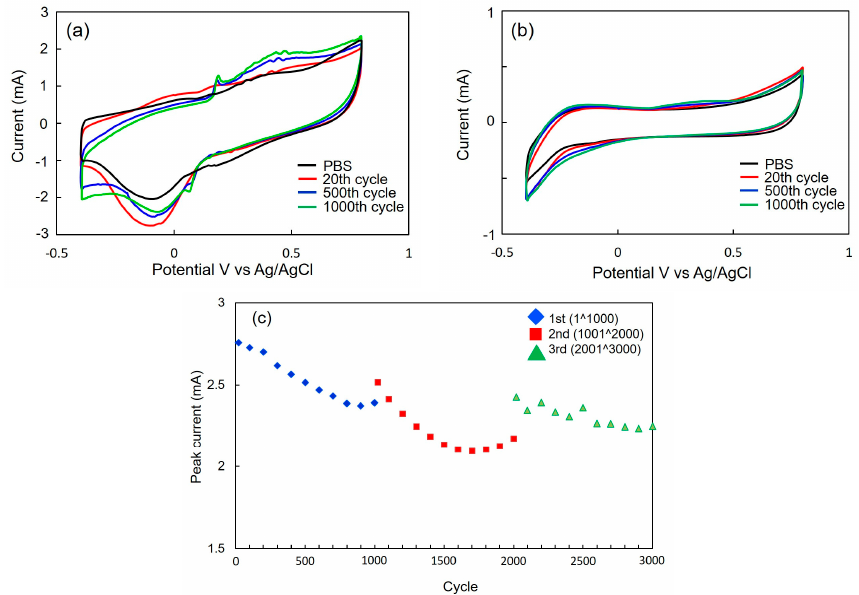
Figure 3. Cyclic voltammogram responses for the 20th, 500th, and 1000th scans of first test of 1000 cycles using ( a ) the Pt-CNW electrode and ( b ) the CNW electrode without Pt nanoparticles in PBS solution with 240 µ M of H 2 O 2 , together with a CV curve for the first scan without H 2 O 2 . ( c ) Variation of peak current value at the potential of –0.1 of CV curves recorded from 1 to 3000